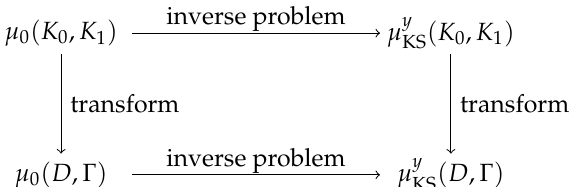
( K ) on the 0 0 , K 1